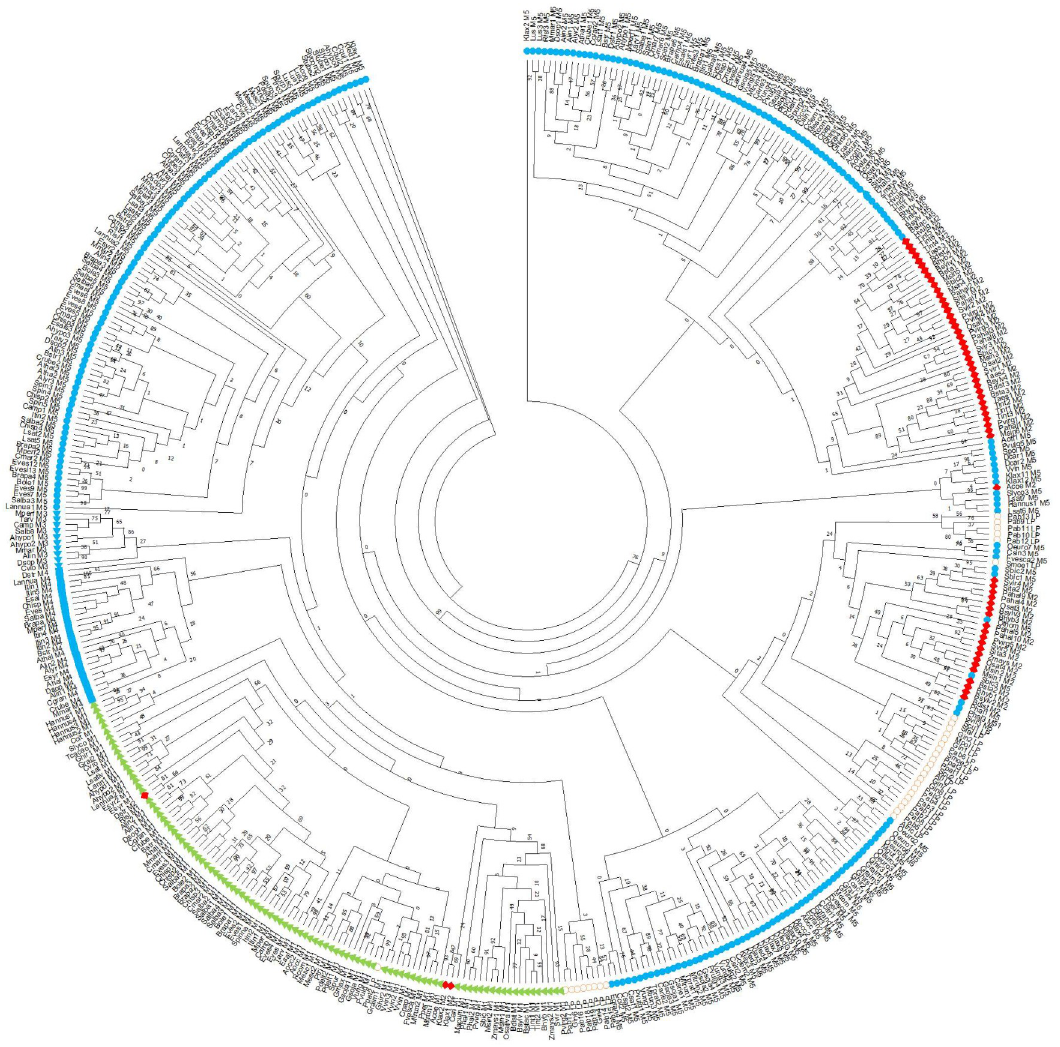
Fig 6. Evolution of LEA3 genes. Phylogenetic tree of LEA3 proteins from higher and lower plants. The tree was created using RAxML with 1000 bootstrap replicates. The bootstrap values are shown at each node. The architectures are coded as follows: MAaRS- 1W, blue circles; MAaRS-2W, blue triangles; MAaRS-no DAELR, blue squares; MGRX, green triangles; M[AS][RK], red diamonds; Lower plants, open circles.